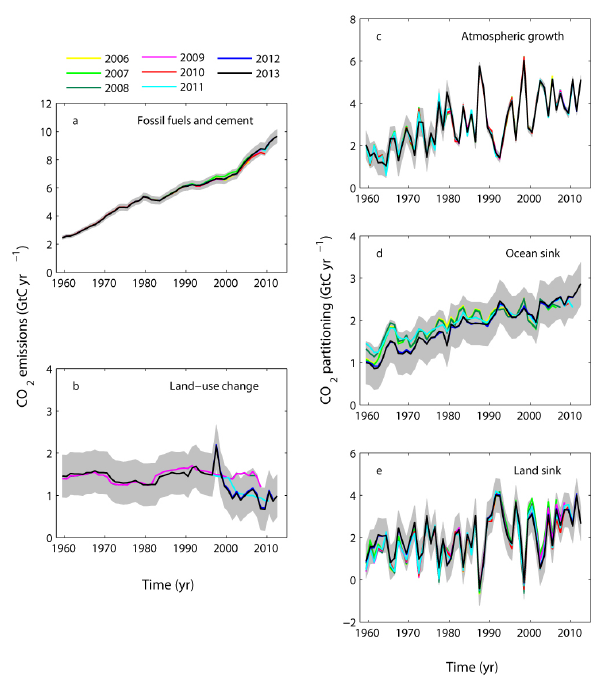
Figure 6. Comparison of global carbon budget components re- leased annually by GCP since 2005. CO 2 emissions from both (a) fossil-fuel combustion and cement production ( E FF ) , and (b) land- use change ( E LUC ) , and their partitioning among (c) the atmo- sphere ( G ATM ) , (d) the ocean ( S OCEAN ) , and (e) the land ( S LAND ) . See legend for the corresponding years, with the 2006 carbon bud- get from Raupach et al. (2007); 2007 from Canadell et al. (2007); to 2008 published online only; 2009 from Le Quéré et al. (2009); 2010 from Friedlingstein et al. (2010); 2011 from Peters et al. (2012b); 2012 from Le Quéré et al. (2013); and this year’s budget (2013). The budget year generally corresponds to the year when the budget was first released. All values are in GtCyr − 1